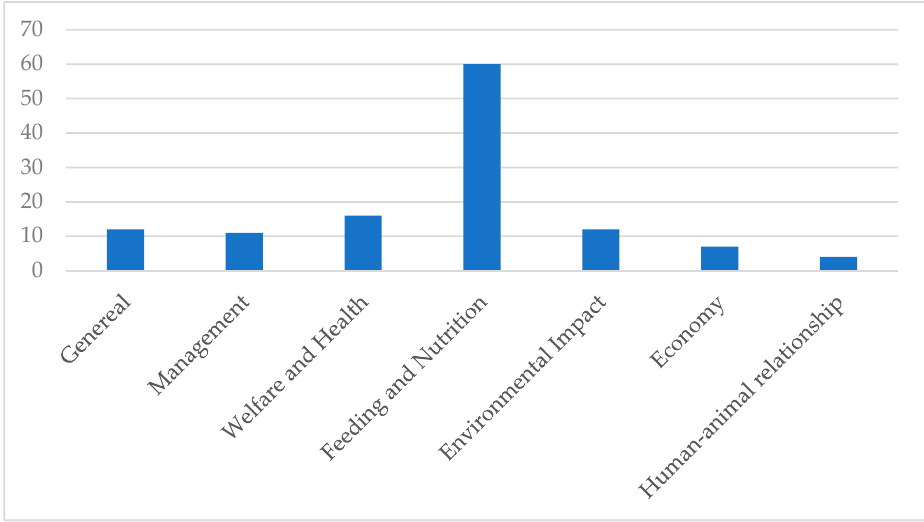
Figure 1. Number of publications per topic.